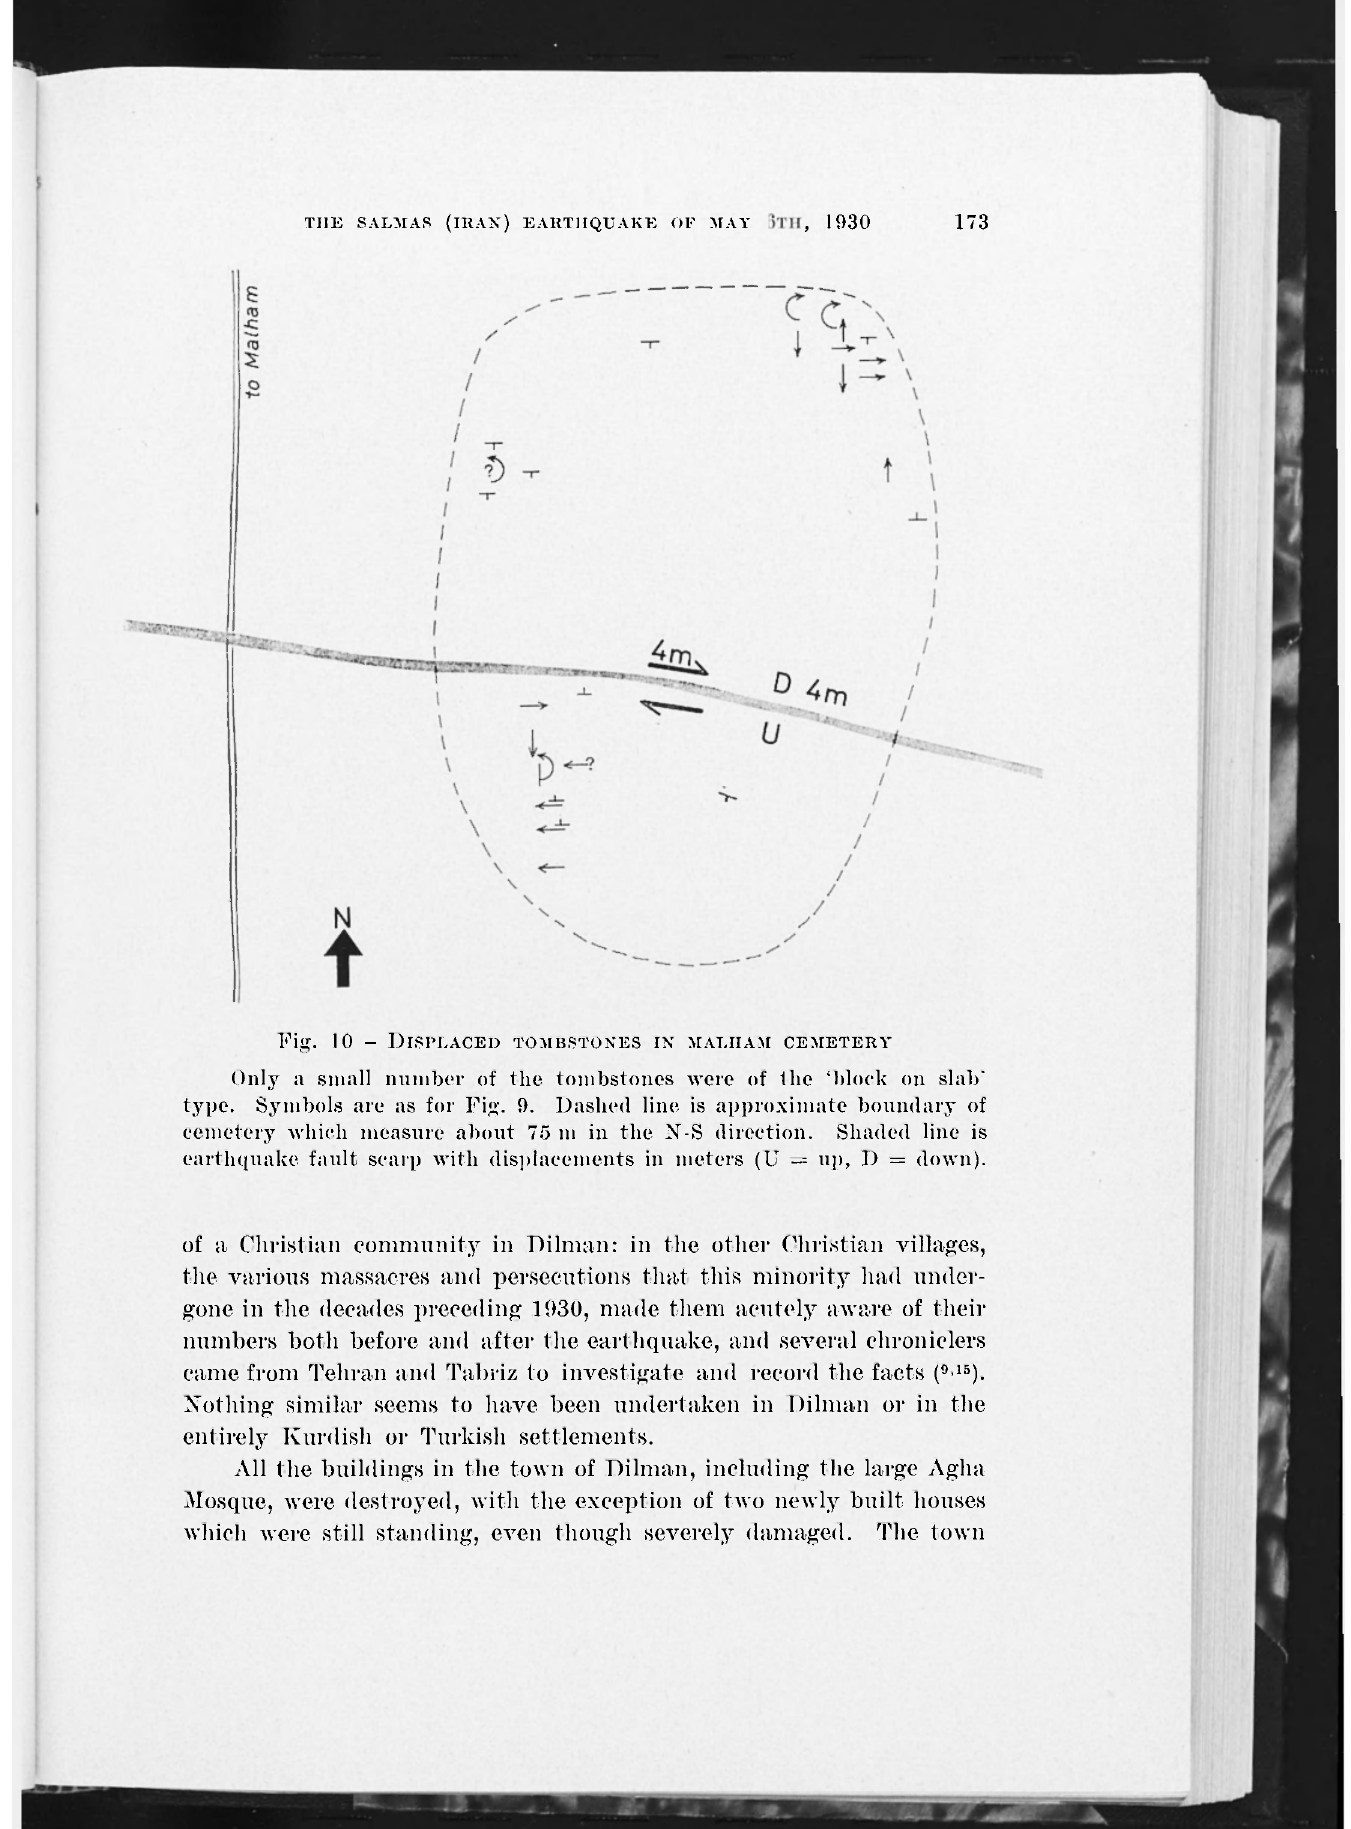
Fig. 10 - DISPLACED TOMBSTONES IN MALIIAM CEMETERY Only a small number of the tombstones were of the 'block on slab' type. Symbols are as for Fig. 9. Dashed line is approximate boundary of cemetery which measure about 75 m in the N-S direction. Shaded line